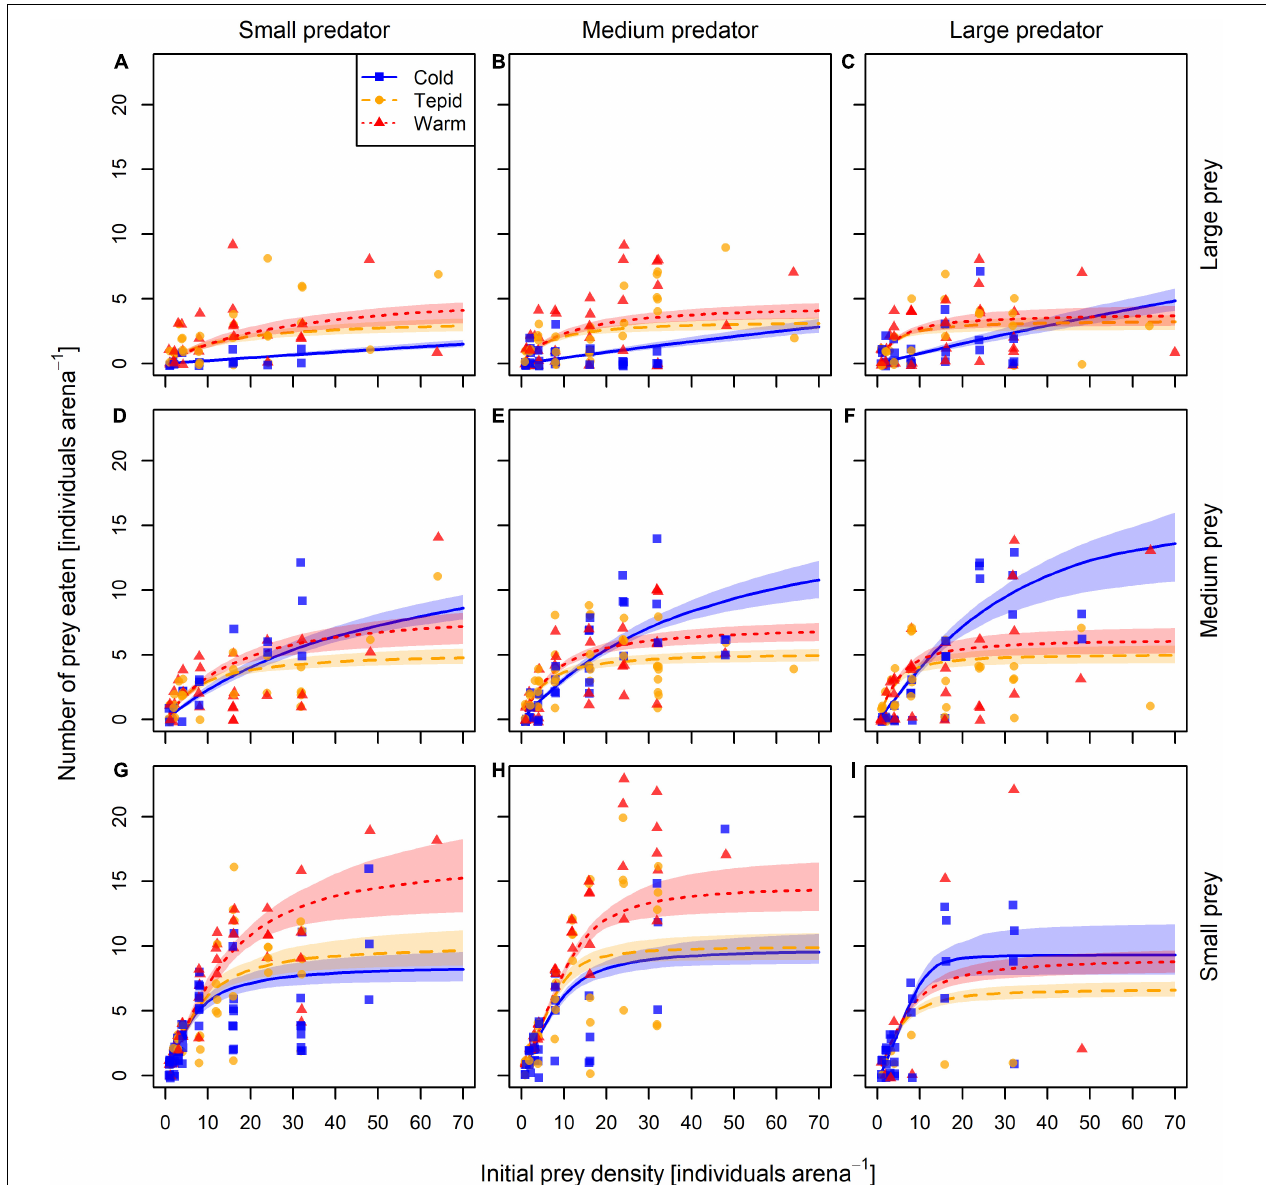
FIGURE 2 | Generalized Type-III functional response curves fitted to the experimental data for each temperature × predator body mass × prey body mass combination. Panels are arranged from (A–I) in approximately increasing order of predator-prey mass ratio. Solid blue, dashed yellow, and dotted red curves (with transparent areas of the same color) represent the model fit ± 95% CI in the cold (5 ◦ C), tepid (10 ◦ C), and warm (15 ◦ C) temperature treatments, respectively. Solid symbols (blue squares, yellow circles, and red triangles) represent individual feeding